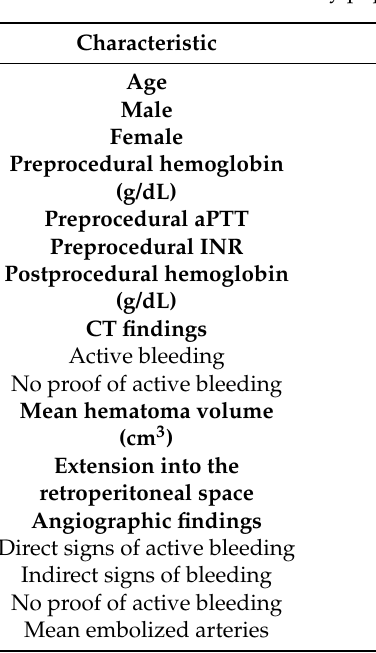
Table 1. Characteristics of our study population and findings at CTA and